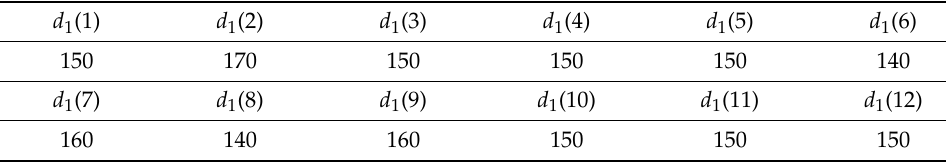
Table 7. Average demand of customer 2.